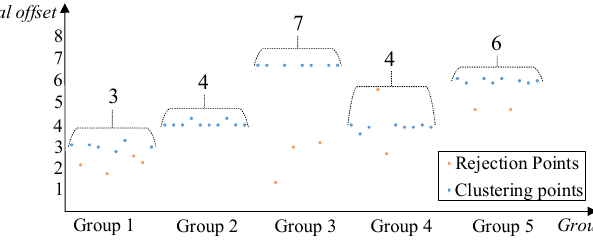
Figure 8. Statistics result of vertical offset.